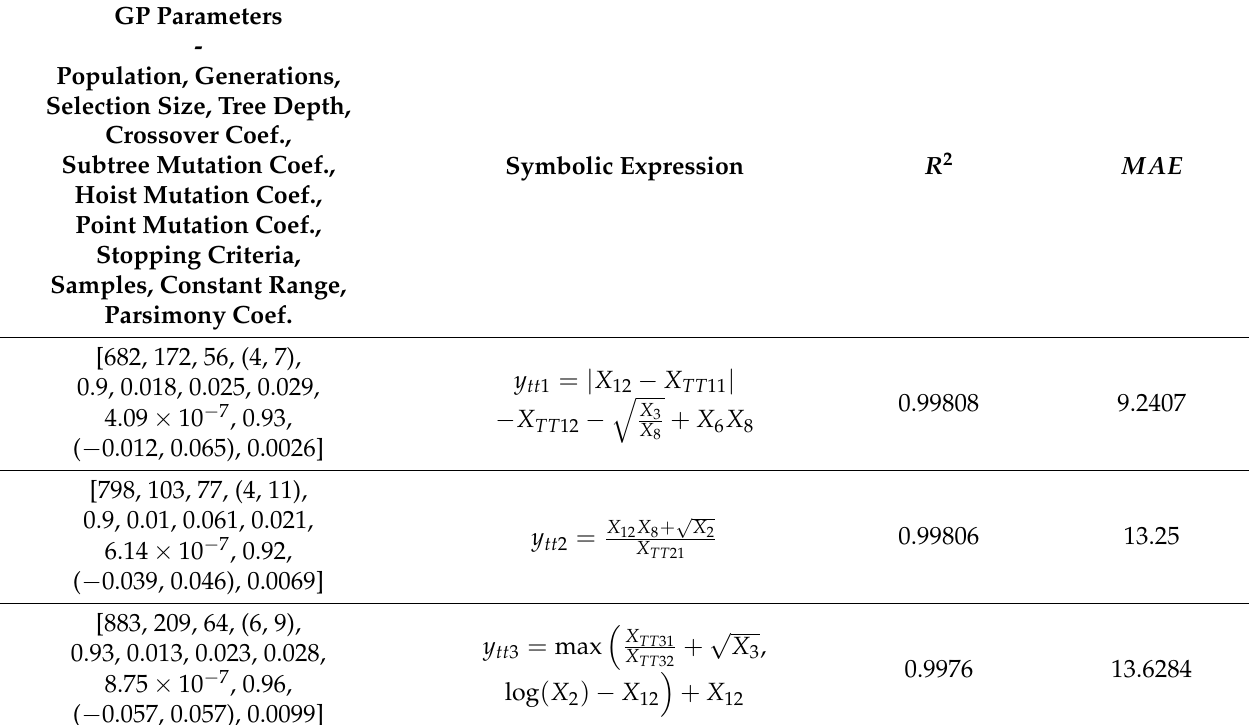
Table 13. Three best symbolic expressions for total propeller torque estimation without decay state coefficients with corresponding R 2 and MAE